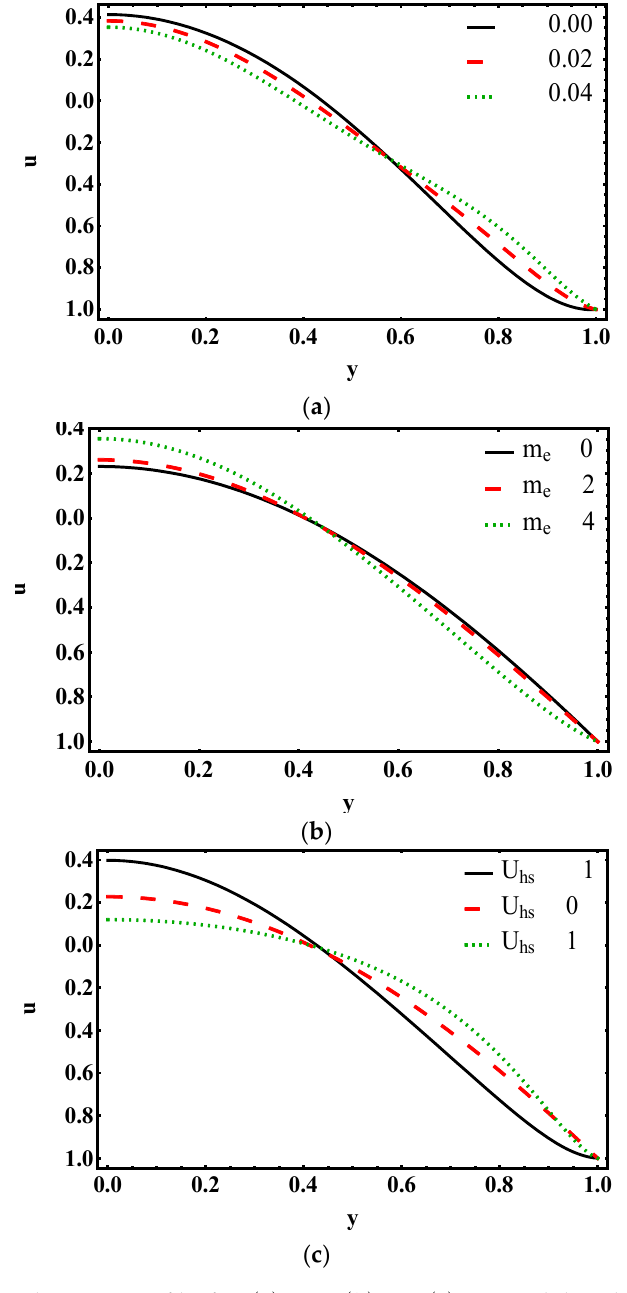
Figure 3. Axial velocity u profile for ( a ) . Г ( b ) m e ( c ) U hs , while other parameters are Г = 0.01, x = π , ε = 0.358, Θ = 0.8, m e = 5, U = −1.